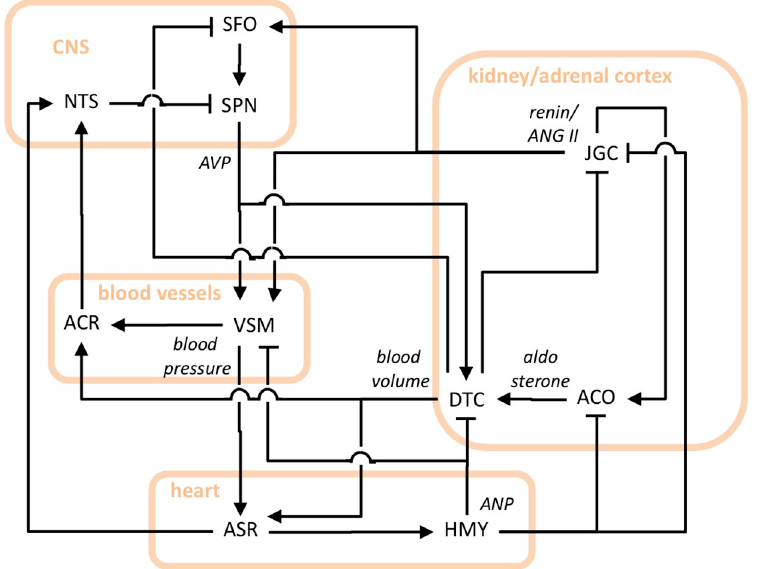
Fig 1. Diagram depicting antagonistic regulatory effects on vasoconstriction and blood pressure due to loop interrelationships among AVP, ANP, and RAAS neuroendocrine systems. Labels for functional agents are the following. ACO: adrenal cortex; ACR: aortic arc and carotid sinus stretch receptors; ASR: atrial stretch receptors; DTC: renal distal tubule and collecting duct; HMY: heart myocytes; JGC: juxtaglomerular cells; NTS: nucleus tractus solitarii; SFO: subfornical organ; SPN: supraoptic and paraventricular nuclei; VSM: vascular smooth muscle. Labels for effect mediators are the following. AVP: arginine vasopressin; ANP: atrial natriuretic peptide; ANGII: angiotensin II; CNS: central nervous system. Lines with arrow ending indicate activation; lines with butt ending indicate